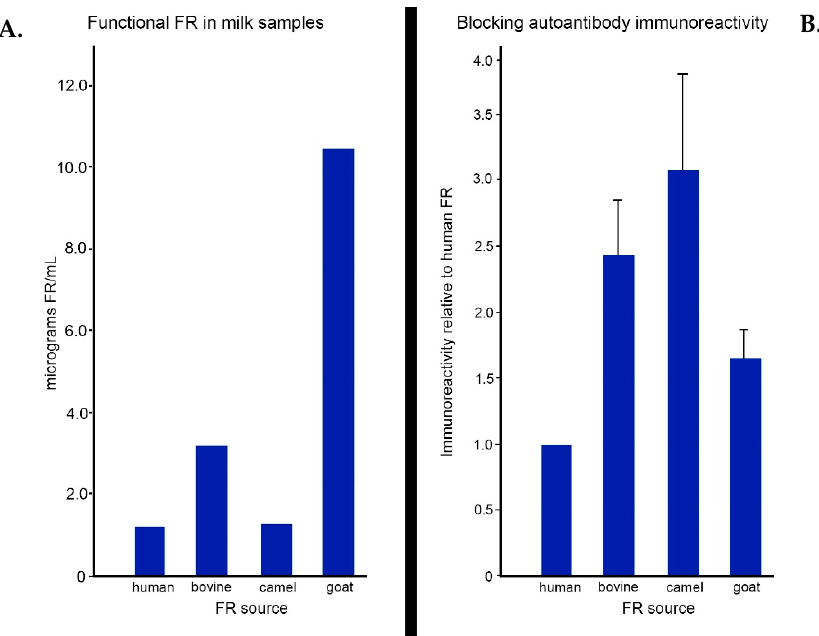
Figure 2. ( A ) Folate receptor concentrations in milk. ( B ) Immune cross-reactivity of blocking autoantibodies against various FR antigens. The blocking assay was performed by testing a known amount of blocking activity in serum samples from 8 different patients with molar equivalent amounts of FR antigens from milk. Blocking activity was determined as pico moles of 3 HPGA blocked and was compared to blocking in human milk antigen.